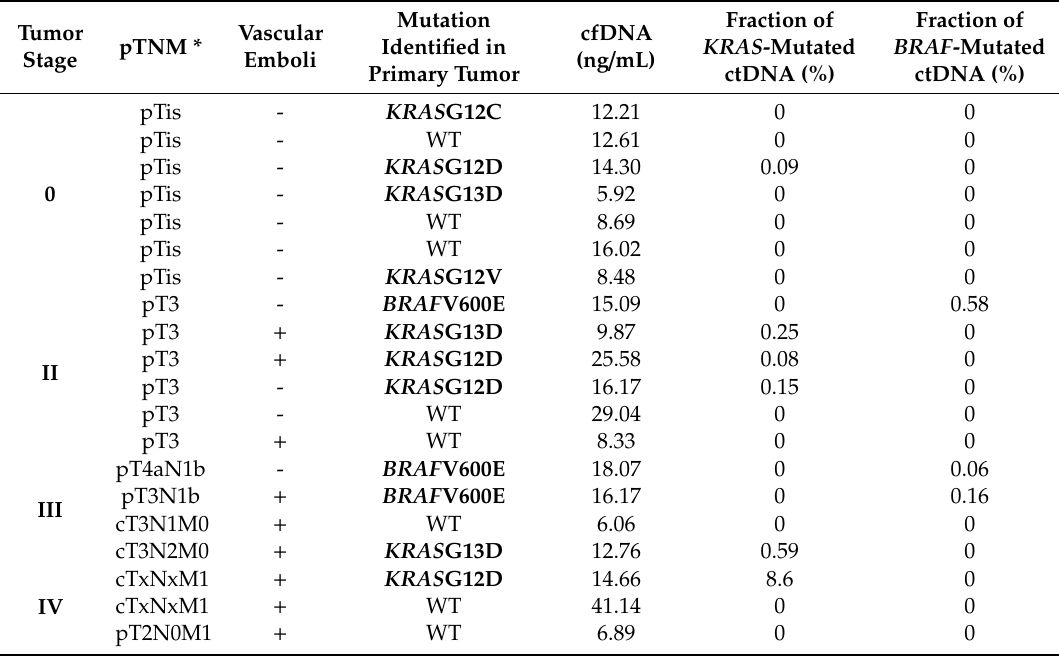
Table 4. Primary tumor and plasma status of “CRC” group.